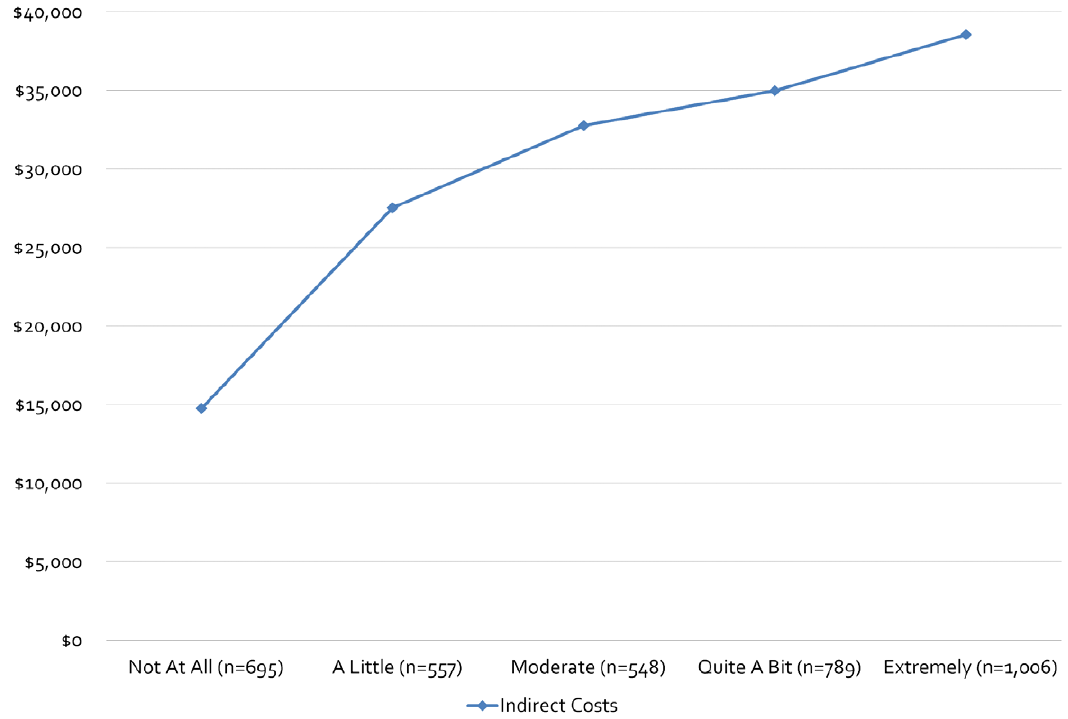
Figure 1. Indirect Costs by 12-Item Multiple Sclerosis Walking Scale Question 6 Responses. MSWS-12 Question 6= ’’In the past two (2) weeks, how much has your MS limited how far you are able to walk?’’.